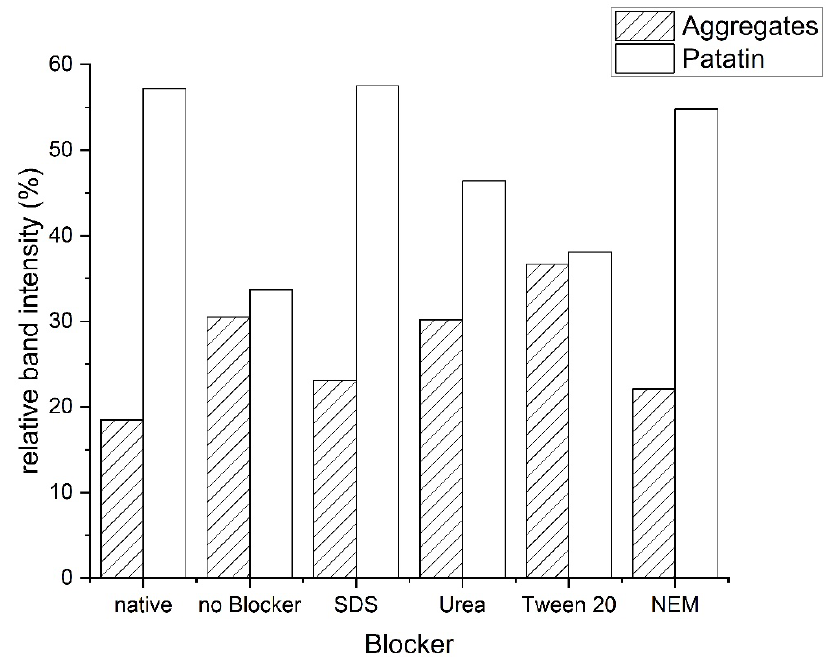
Figure 6. Relative amount of protein in the aggregate and patatin fraction under non-reducing conditions in the presence of different blocking substances. The heating was done 10 ◦ C above T d for 30 min. The band intensity was taken from one SDS-PAGE gel under non-reducing conditions. The solution heated in the presence of NEM formed a weak gel. This indicated a strong influence of the thiol groups on the aggregation behavior of PPI.